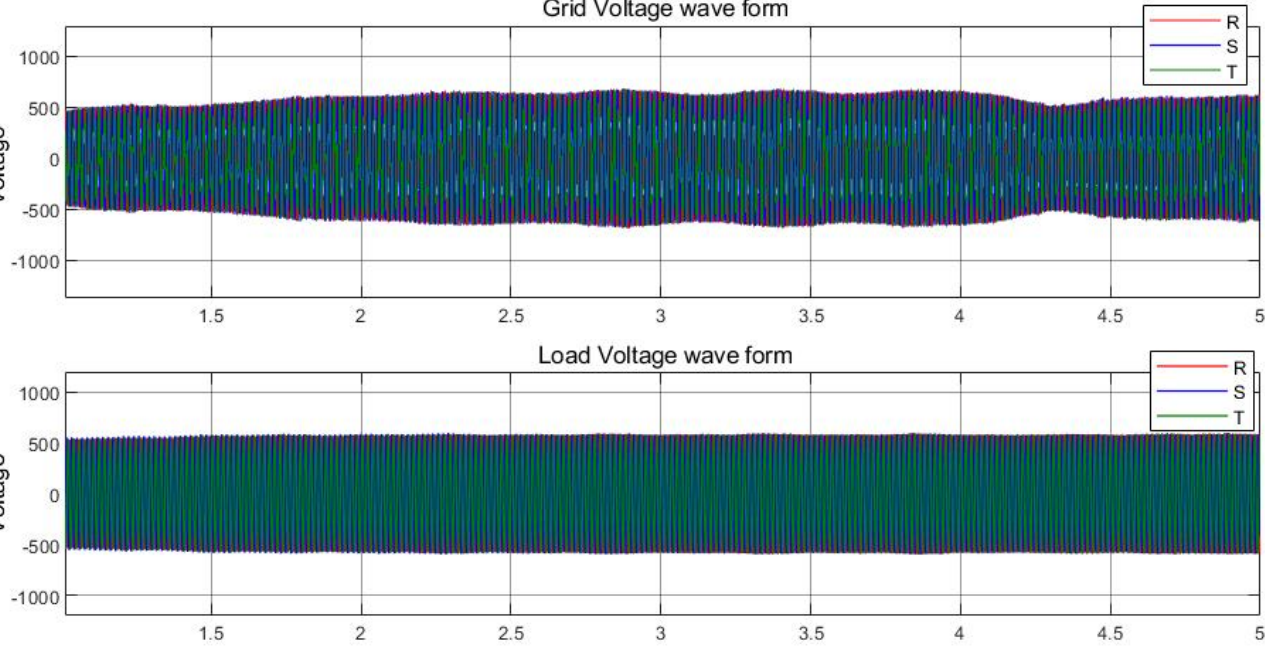
Figure 25. Load-side voltage and grid-side voltage amplitude with non-linear load on the load side using PWM.